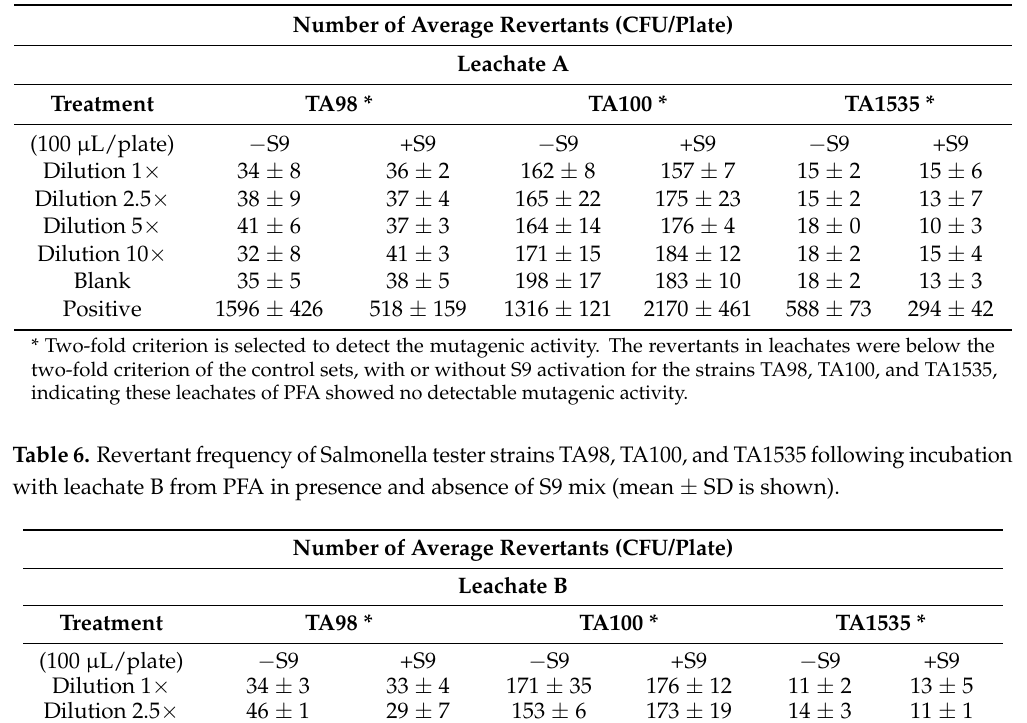
Table 5. Revertant frequency of Salmonella tester strains TA98, TA100, and TA1535 following incubation with leachate A from PFA in presence and absence of S9 mix (mean ± SD is shown).